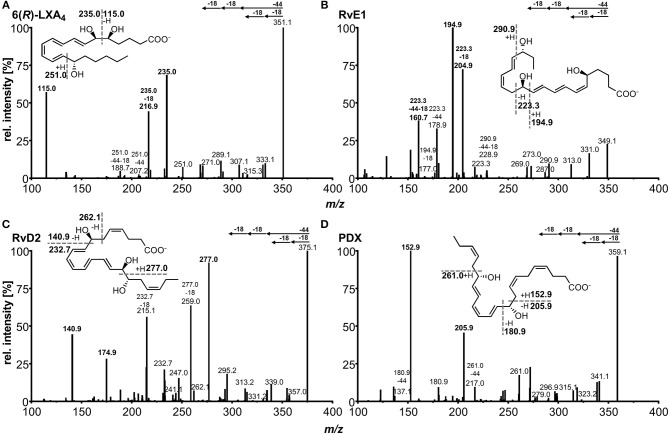
Collision induced dissociation (CID) product ion spectra of representative SPMs comprising (A) ARA derived lipoxin 5(S),6(R),15(S)-LXA4, (B) EPA derived E-series resolvin RvE1, (C) DHA derived D-series resolvin RvD2, (D) DHA derived protectin PDX. The dashed lines in the structures depict suggested sites of fragmentation leading to specific transitions.